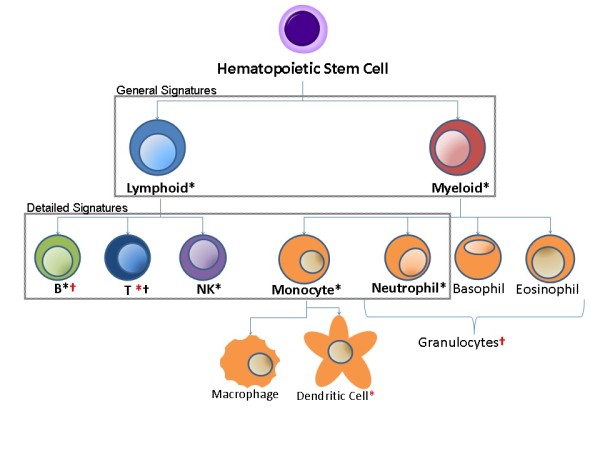
Hematopoietic lineage tree. Cell subset-specific gene expression signatures were obtained from Abbas et al. [12] (marked with *) and Palmer et al. [13] (marked with †). Only one signature for each subset was chosen for use in SPEC (black symbols). The remaining signatures (red symbols) were utilized as part of the independent subset validation (Table 3).